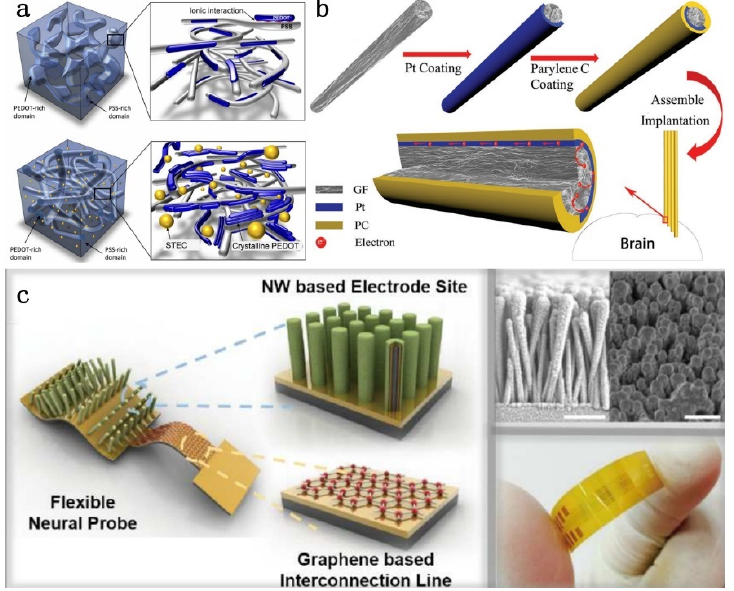
Figure 2. Electrode material: ( a ) PEDOT:PSS conductive polymer film (above without STEC, below with STEC [36] ; ( b ) GF-Pt microelectrode [66] ; and ( c ) nerve probes based on graphene, ZnO nanowires and conductive polymers [63] .